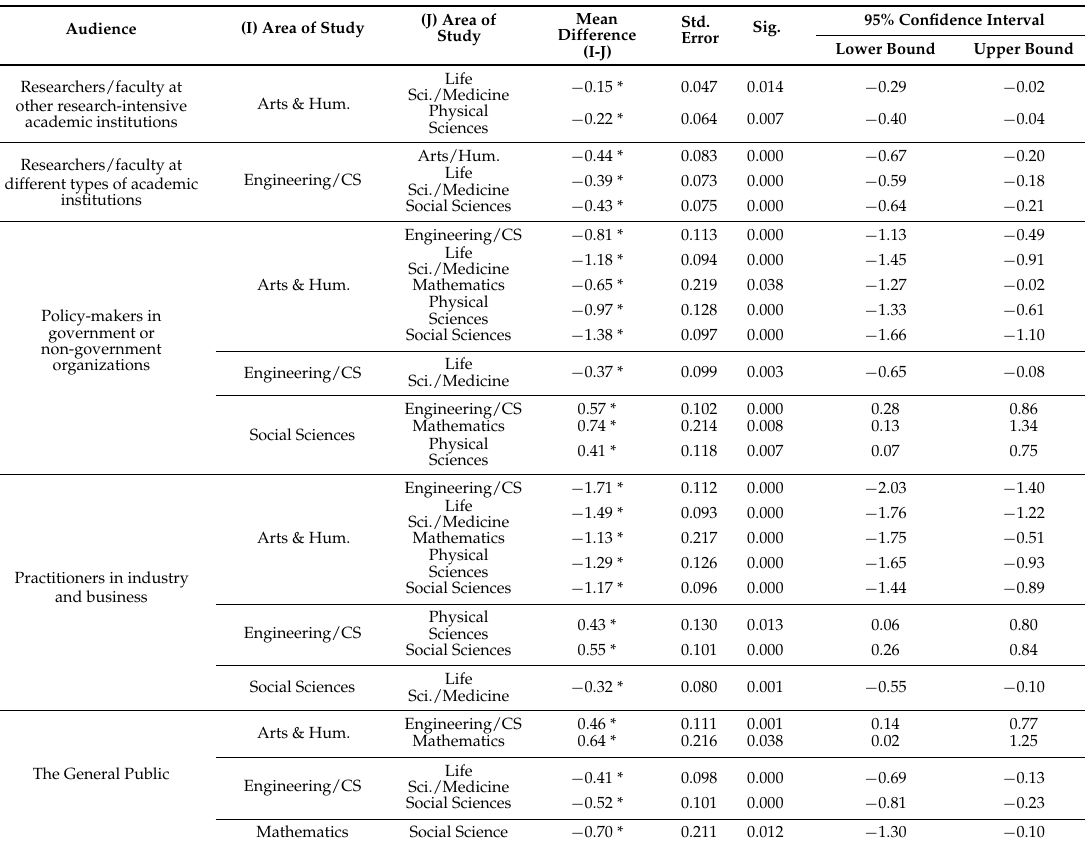
Table 15. Multiple comparisons, accessibility for different audiences by subject discipline (Tukey HSD).